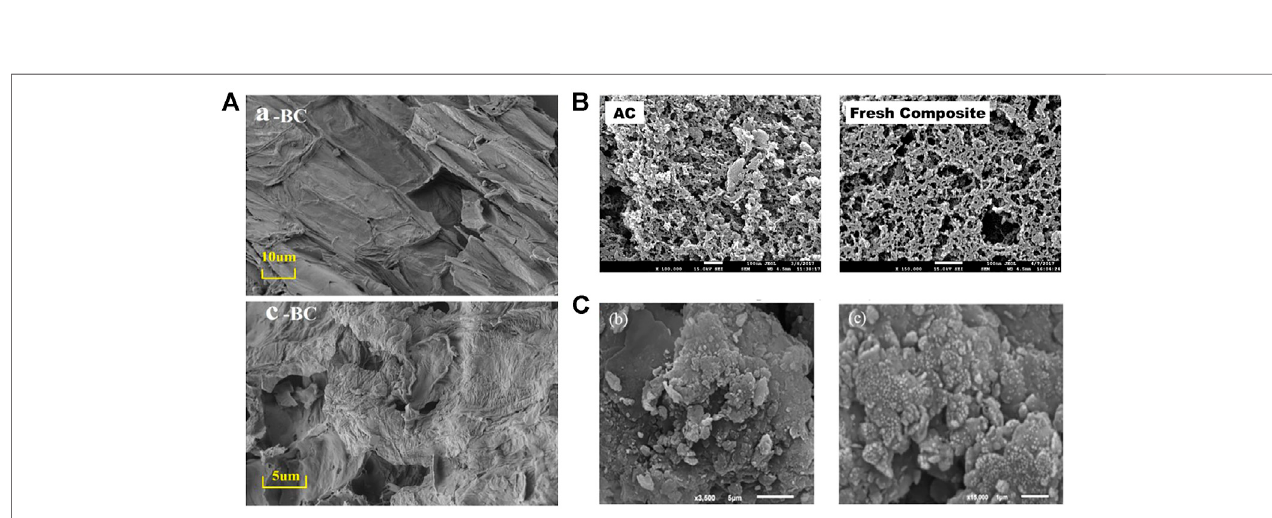
FIGURE 3 | Rough surface of biochar (A) (Zhang X. et al., 2021), activated carbon (B) (Mullick and Neogi 2018), and clay (C) (Mobarak et al., 2018).